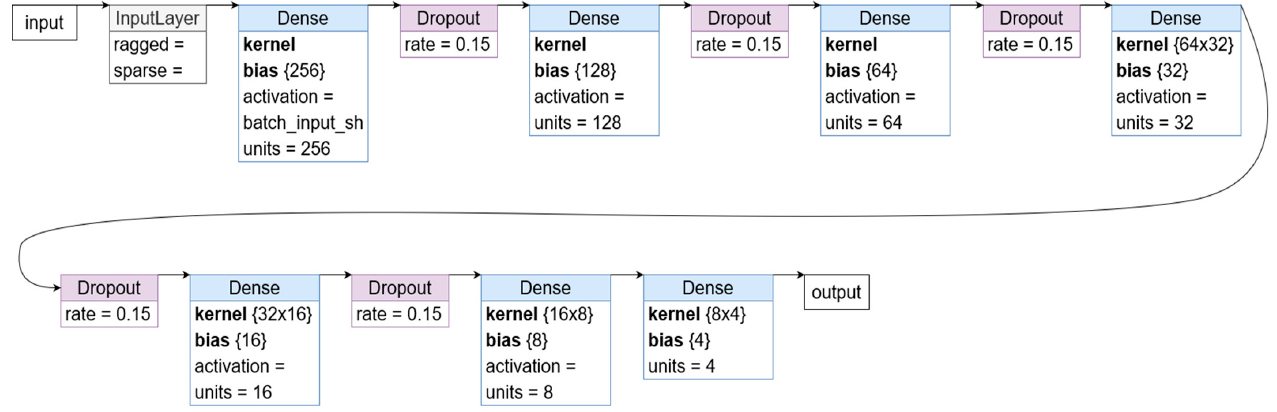
Figure 4. Visual representation of the developed DL model.